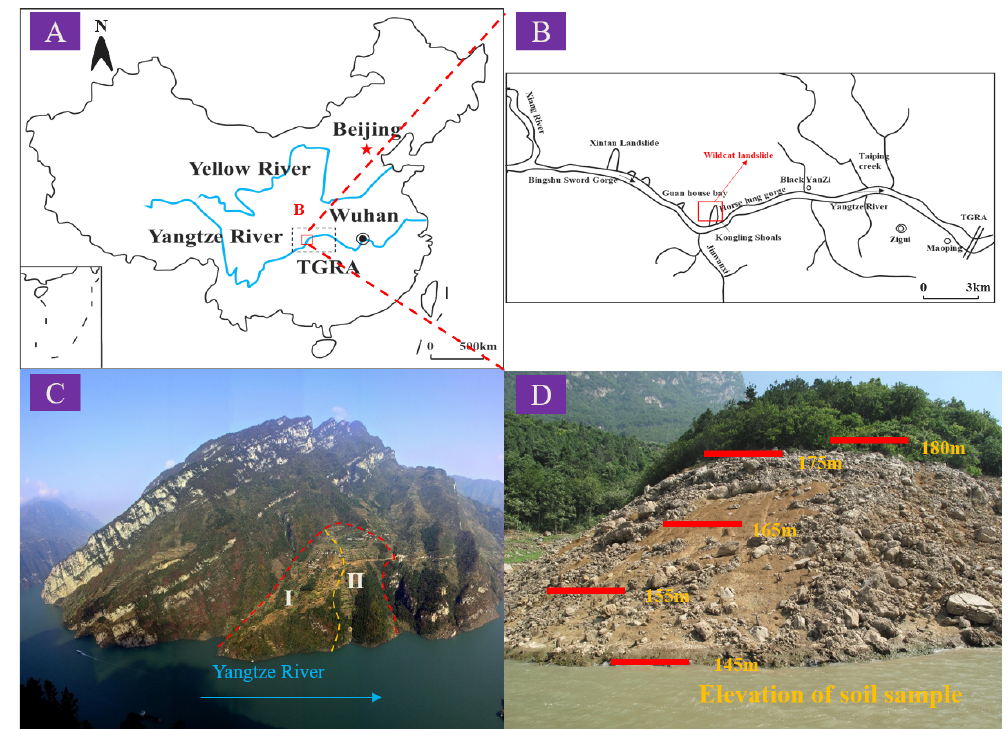
Figure 1. Sampling spot. ( A , B ) is the position of theWildcat landslid; ( C ) shows the full picture of Wildcat land; field sampling is shown in ( D